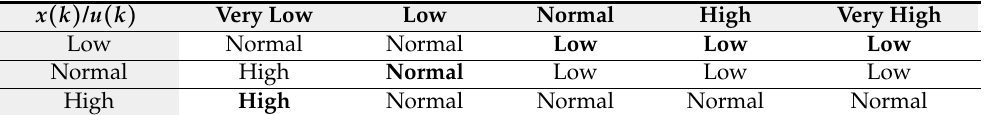
Table 2. Example of a state table for a component of the vector of emotions x ( k + 1 ) (function f ). The gray cells represent the different input and states allowed by the system.